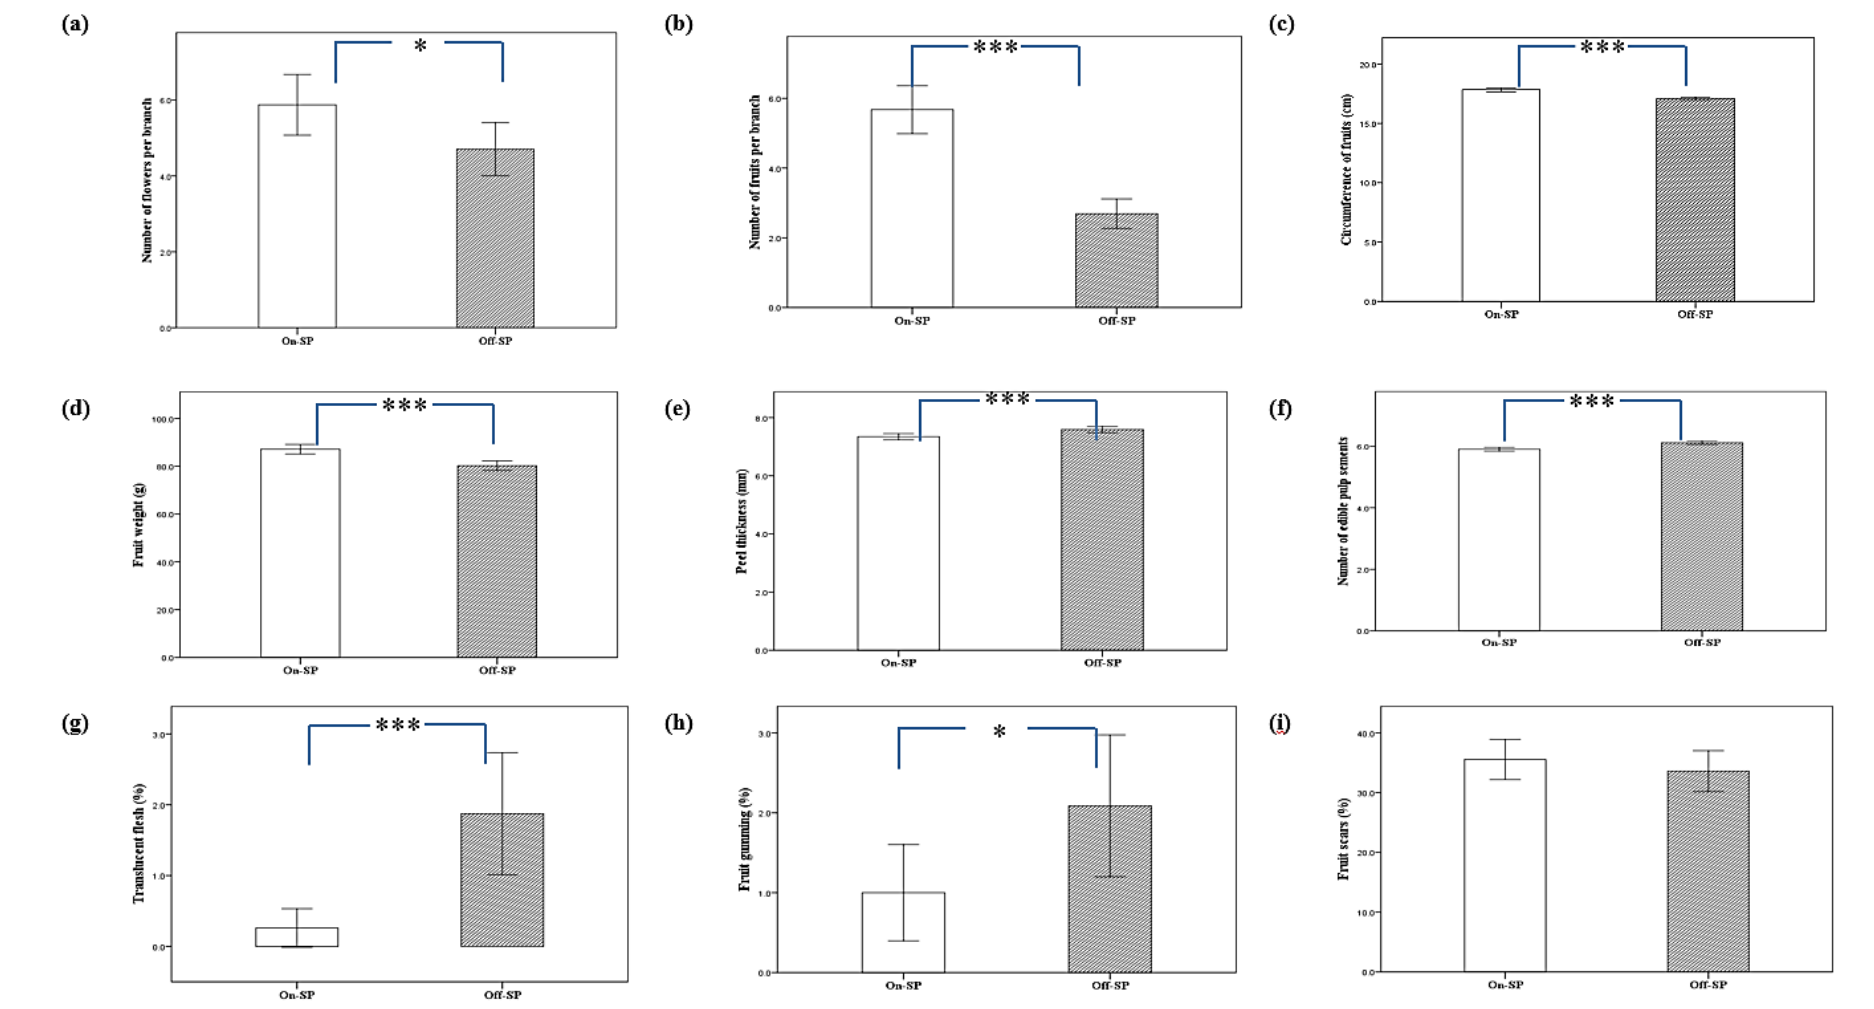
Figure 3. Mangosteen parameters in the on-season and off-season mangosteen production periods. (a) Number of flowers per branch, (b) Number of fruits per branch, (c) Circumference of fruits (cm) (d) Number of edible pulp segments, (e) Fruit weight (g), (f) Peel thickness (mm), (g) Translucent flesh (%), (h) Fruit gumming (%) and (i) Fruit scar (%). (* P < 0.05, ** P < 0.01, *** P <